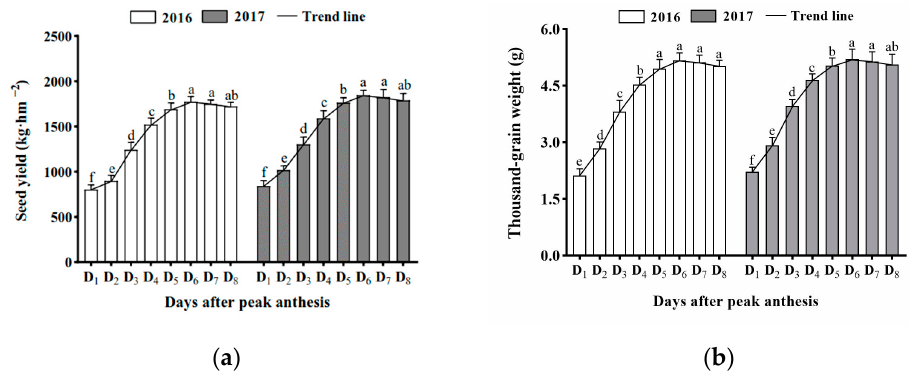
Figure 3. The seed yield ( a ) and thousand-grain weight ( b ) (mean ± standard error, n = 4) of K. melanthera as influenced by days after peak anthesis of seeds during the trial years of 2016–2017. For different days after peak anthesis, values with the different letter are significantly different based on Bonferroni’s t -test ( p < 0.05). The standard error of the mean is shown by a vertical bar. Note: